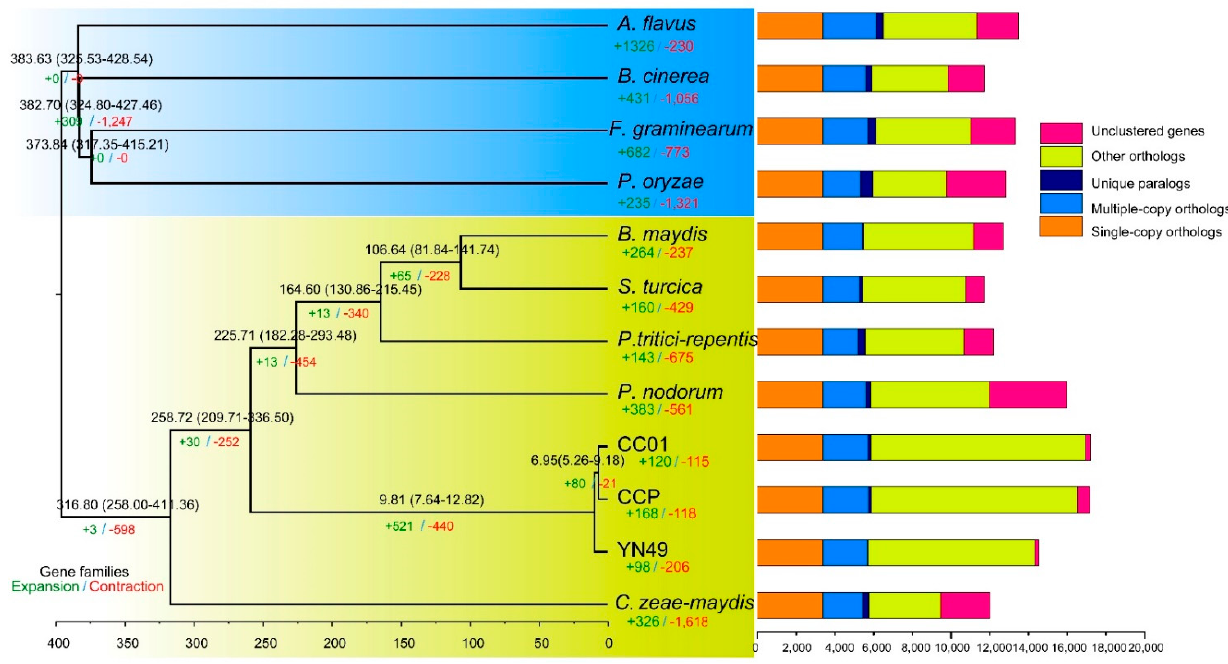
Figure 2. Phylogenetic relationships between C. cassiicola YN49 and CC01 strains and 10 other phytopathogenic fungi. Eurotiomycetes and Leotiomycetes fungi are indicated by a blue background, and yellow indicates Dothideomycetes fungi. Divergence times are labelled blue, gene family expansion and contraction are enumerated below the species names in green and red, respectively, and gene categories are shown on the right.